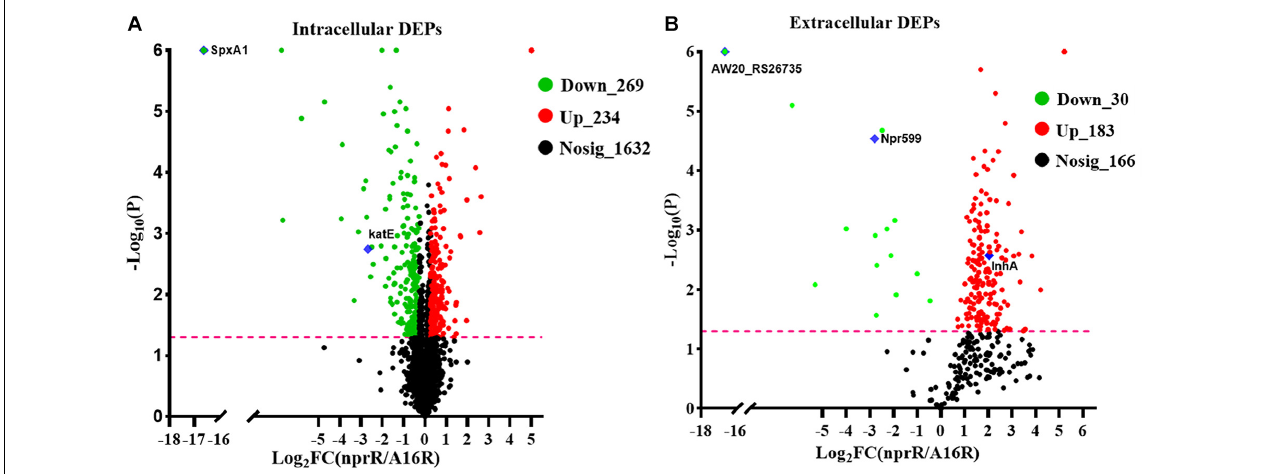
FIGURE 3 | Volcano plots of differentially expressed proteins (DEPs) in the nprR deletion mutant and A16R strain. The plots show log2-fold change (FC) and –log 10 ( p -value) comparisons of the DEPs from the nprR deletion mutant strain against the A16R strain. A FC > 1.2 was used to identify upregulated DEPs and a FC < 0.83 for downregulated DEPs. (A) intracellular protein fraction. (B) Extracellular protein fraction. Green, red, and black points represent downregulated, upregulated, and non-differentially regulated proteins, respectively. The pink line represents FDR = 0.05. Some focused proteins are marked with blue diamonds.